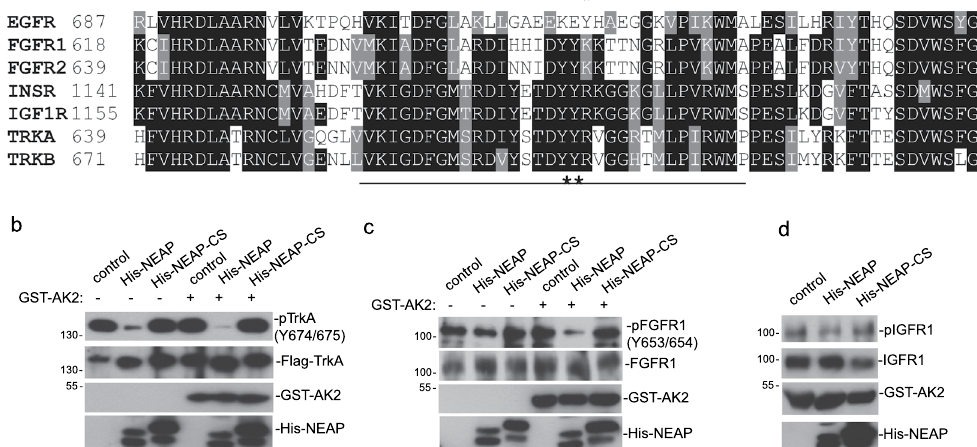
Figure 4. NEAP dephosphorylates TrkA and FGFR1 directly. ( a ) Activating loop sequences of EGFR, FGFR1, FGFR2, IGFR1, INSR, TrkA, and TrkB were aligned using the Clustal Omega and Boxshade programs. Identical and homologous amino acid residues were shown by black and grey shades, respectively. Dual Tyr-phosphorylation sites were indicated by bold asterisks. EGFR Tyr 845 was indicated by an asterisk. ( b ) Flag-tagged pTrkA was immune-precipitated from transfected H1299 cells and was subjected to NEAP dephosphorylation with or without the GST-AK2 presence. The levels of pTrkA/TrkA in the reaction mixtures were examined by immune-blotting using indicated antibodies. ( c and d ) Rat FGFR1 and IGFR1 were immunoprecipitated from PC12 cells and subjected to NEAP dephosphorylation in the presence or absence of GST-AK2. The levels of pFGFR1/FGFR1 (panel c) and pIGFR1/IGFR1 (panel d) in the reaction mixtures were examined by immune-blot analyses using indicated antibodies.